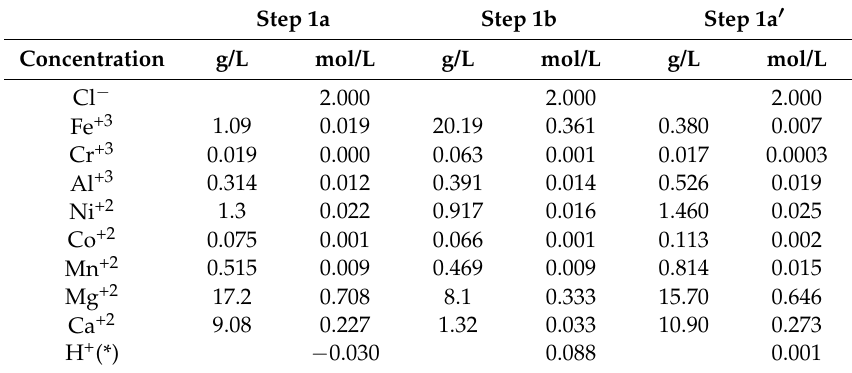
Table 4. Composition of PLS streams obtained by the CCL (steps in Figure 2).